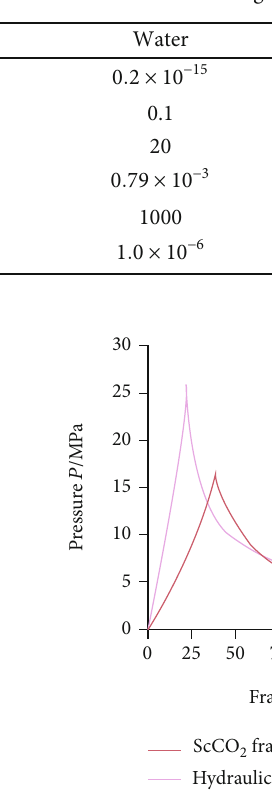
Figure 12: The numerical model for fracturing in coals. Table 3: Numerical simulation parameters of the di ff erent fl uid fracturing in coals.